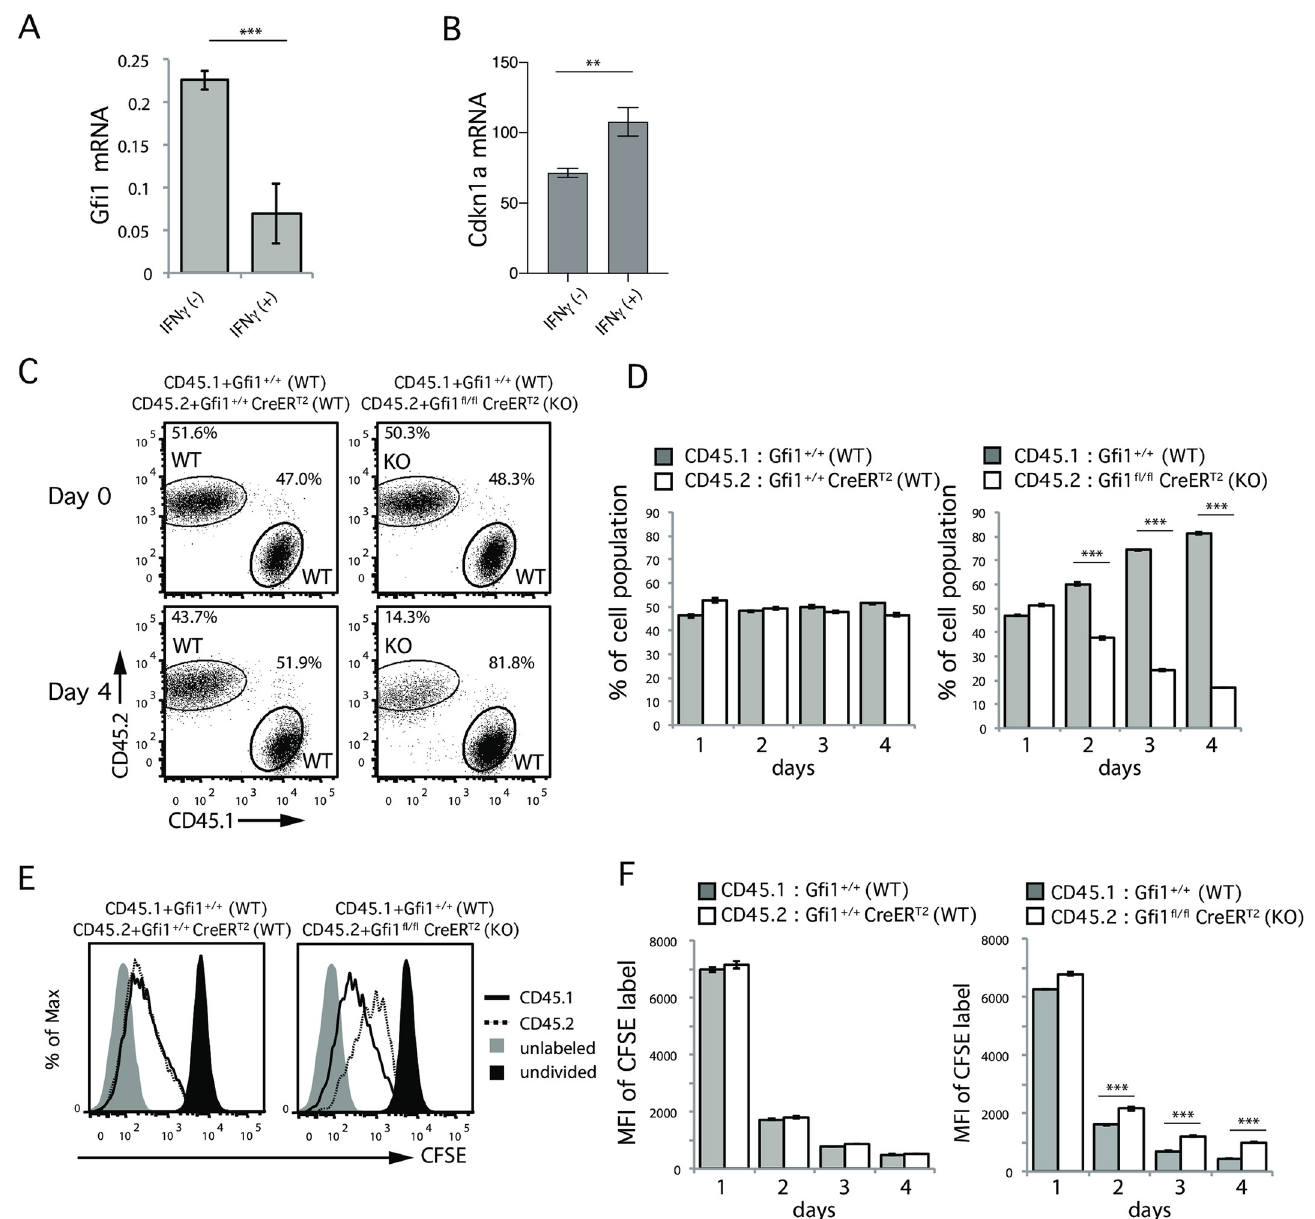
Fig 2. Loss of Gfi1 leads to impaired Th2 cell proliferation. (A) The Gfi1 mRNA expression relative to Hprt on Th2 cells after treatment with or without IFN γ for 2 days. Error bars represent the mean ± SD. Data are representative of three independent experiments. (B) The Cdkn1a mRNA expression relative to β -actin on Th2 cells after treatment with or without IFN γ for 4 days. (C and D) Relative cell expansion of Gfi1 fl/fl CreER T2 (KO, CD45.2) or Gfi1 +/+ CreER T2 (WT, CD45.2) Th2 cells in comparison to CD45.1 WT Th2 cells on day 4 of culturing in the presence of 4-OHT (C). The percentages of CD45.2 (WT or KO) or CD45.1 (WT) Th2 cells were measured on the indicated days (D). (E and F) Histogram of the CFSE expression on Th2 cells on day 4 of culturing in the presence of IFN γ (E). The MFI of CFSE on Th2 cells on the indicated days of culture in the presence of IFN γ was determined (F). ��� p < 0.001 (Student’ s t